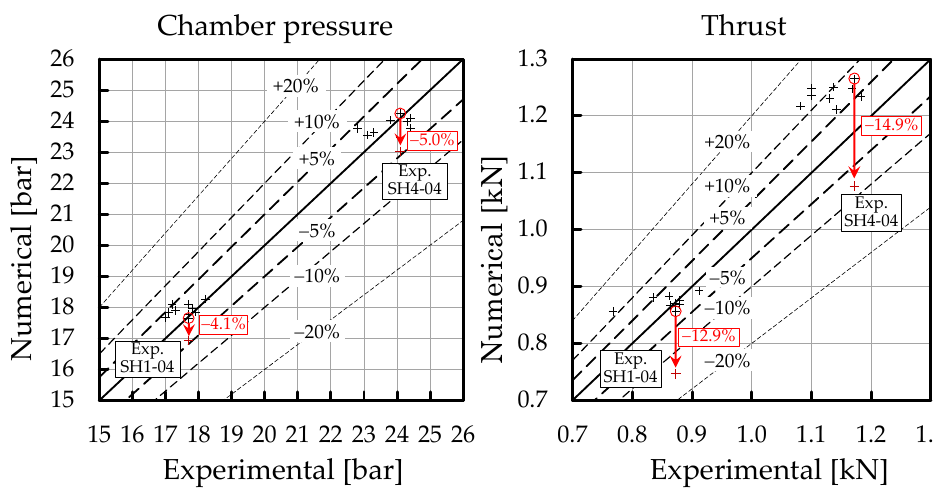
Figure 15. Impact of the frozen equilibrium model on P ch ,num and F num for the simulations of experiments SH1-04 and